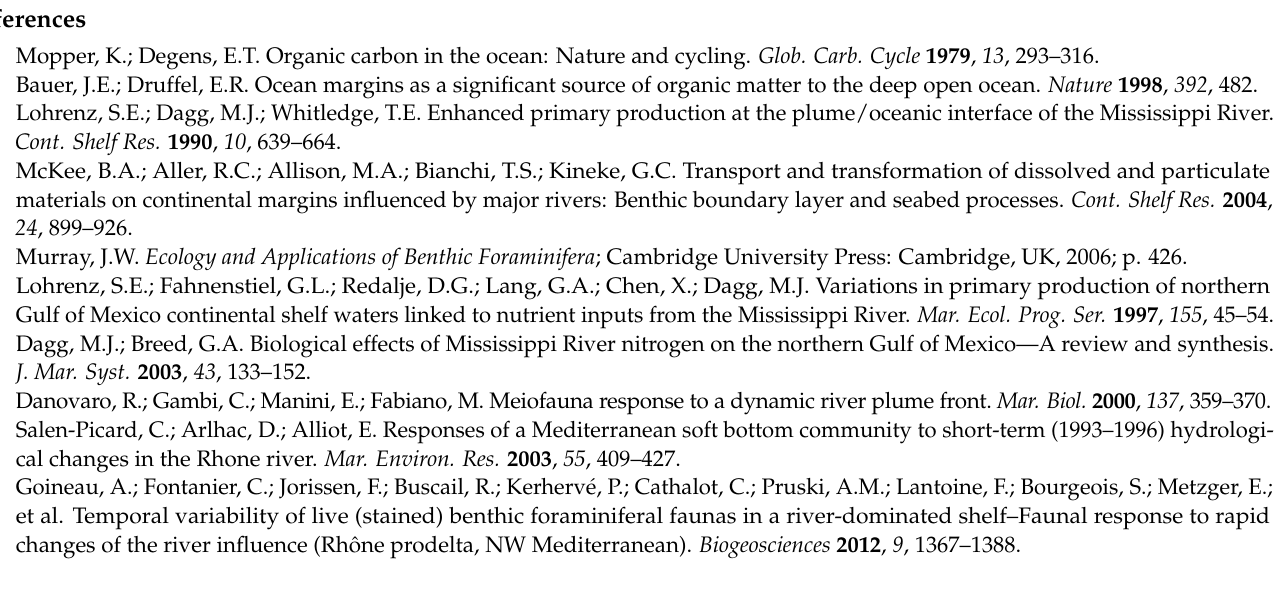
Table S3: List of taxa considered allochthonous and their living depth